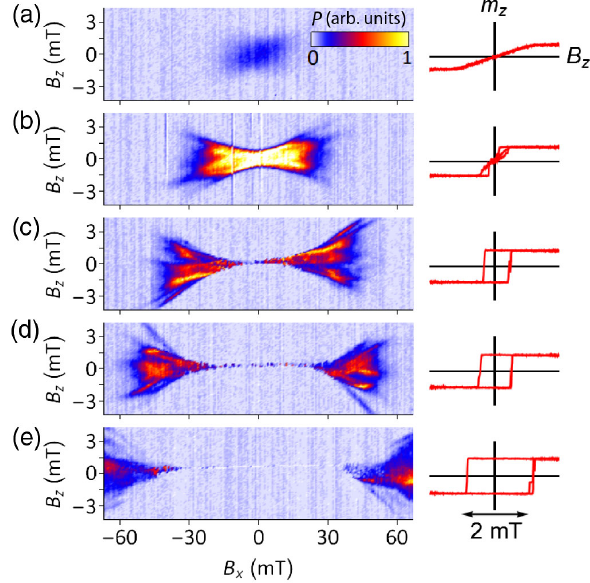
FIG. 6. Intensity maps of the integrated magnetization noise P ð B ; B Þ at different locations across the Pt = Co = Pt sample, x z beginning in (a) regions of the sample with in-plane magnetiza- tion, where P is small. (b) Near the SRT, P is large when j B z j < B (cf. Fig. 5). (c) – (e) In regions with less disorder and therefore sat increasingly stable perpendicular magnetization, μ 0 H c increases and fluctuations vanish at B x;z ¼ 0 . However, strong fluctuations reemerge when larger j B x j is applied. Note that the m z ð B z Þ magnetization curves are all acquired at B x ¼ 0 using a rapidly varying B z (several Hz). This gives an open hysteresis loop with large switching (coercive) fields in panels (c) – (e). In the corre- sponding noise maps, B z was ramped much more slowly (mHz), so that the film switched at very small B z